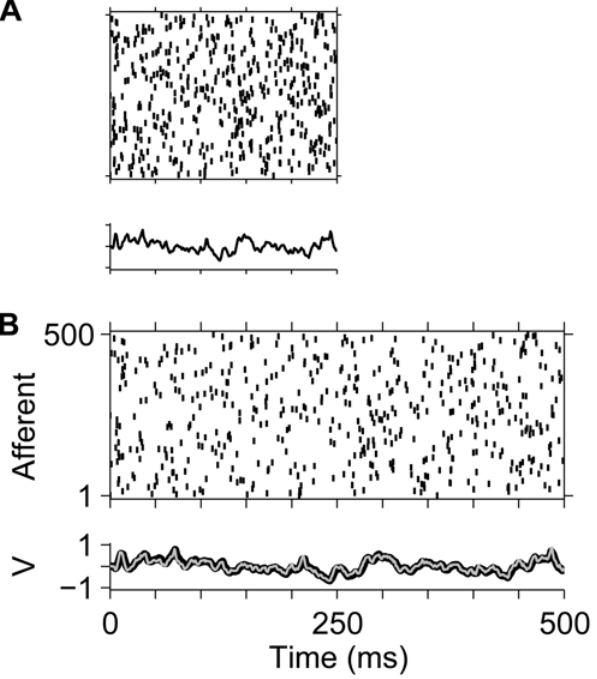
Figure 2. Time-warp–invariant voltage traces. Spike rasters show a random spike pattern across N =500 afferents ( N ex =250 excitatory and N in =250 inhibitory), each of which fires a single action potential at a random time chosen uniformly between 0 and 500 ms. Whereas the original spike pattern ( b =1) is shown in (B), the pattern displayed in (A) is compressed by a factor of b =0.5. In each panel, the lower trace depicts the voltage V ( t , b ) induced by the spike patterns in our model neuron with balanced uniform synaptic peak conductances that resulted in a zero mean synaptic current at rest set to ~ 6 = N ~ 5 g max max g max for inhibitory ex t s ð Þ for excitatory synapses and g ex ex in synapses. These values result in a mean total synaptic conductance of G syn & 7 g leak . In (B), the voltage trace V ( t ,1) (thin grey line) is superimposed on the rescaled voltage trace V ( b t , b ) (thick black line) from (A).